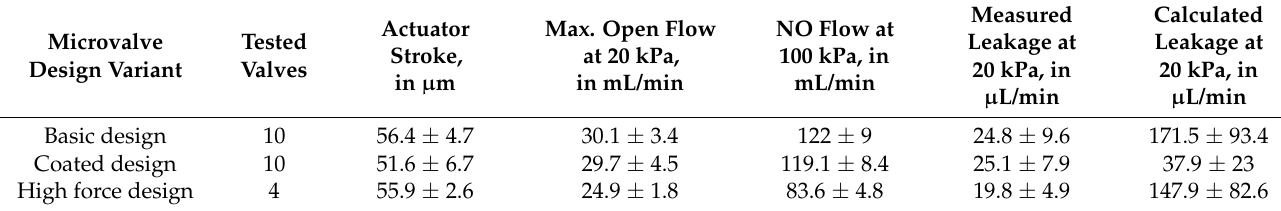
Table 2. Overview of the experimental results for the three studied design variants of the NO microvalve.